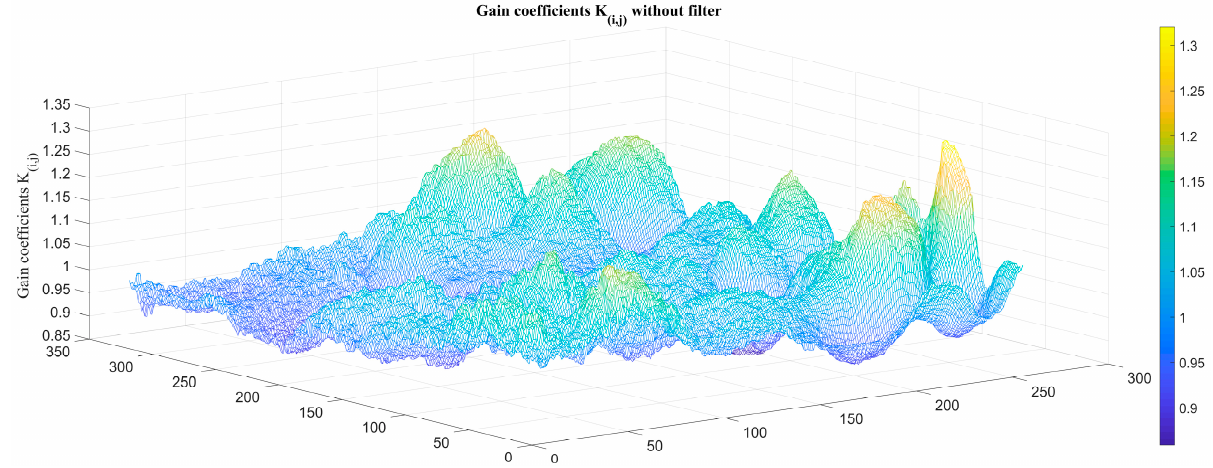
Figure 9. TPC gain coefficients K i,j without atmospheric transmittance filter.